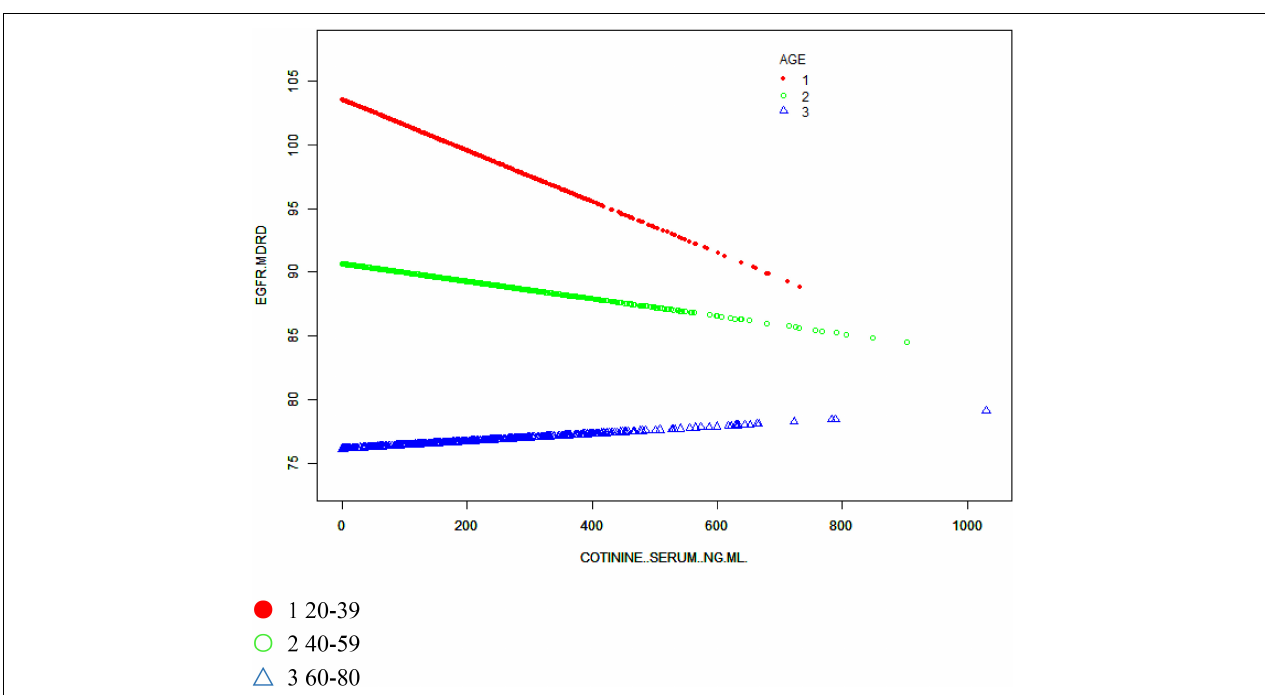
FIGURE 5 | The association between serum cotinine and the eGFR stratified by age. Age, sex, educational background, the ratio of family poverty to income, marital status, BMI, glycosylated hemoglobin, blood glucose, BUN, triglycerides, and uric acid albumin were